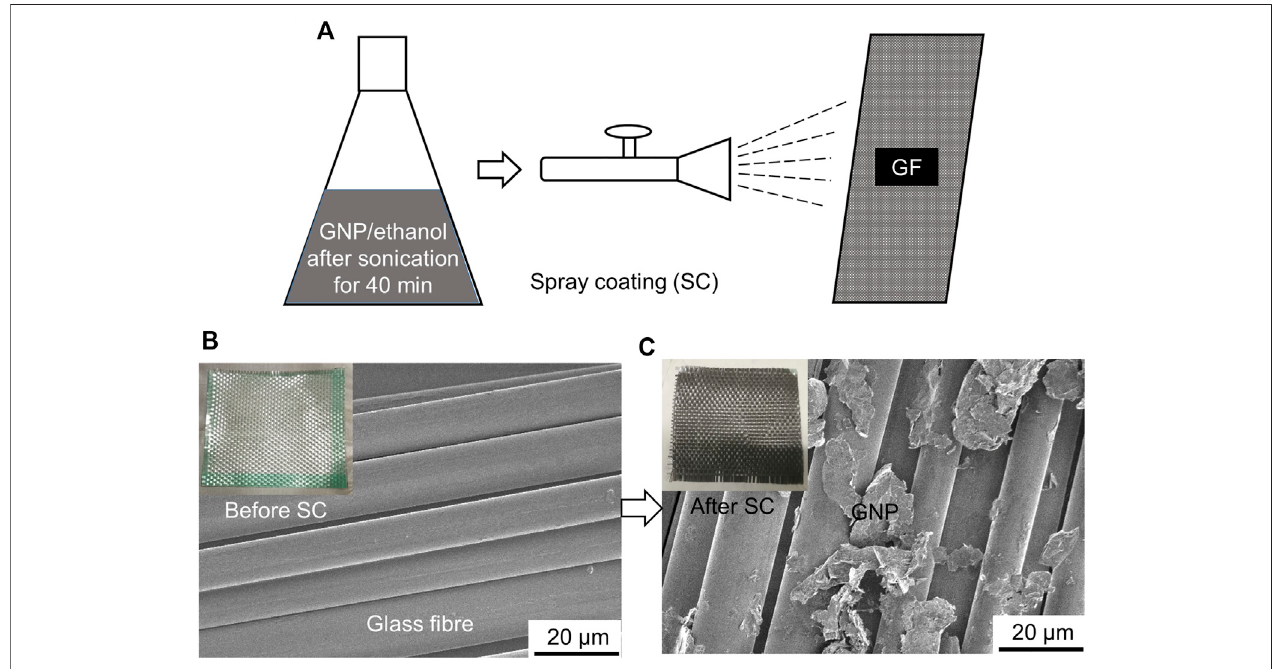
FIGURE 3 | (A) Schematic of the spray-coating process. SEM images of glass fabric (B) before and (C) after spray-coated with GNPs. Embedded images are optical photos.